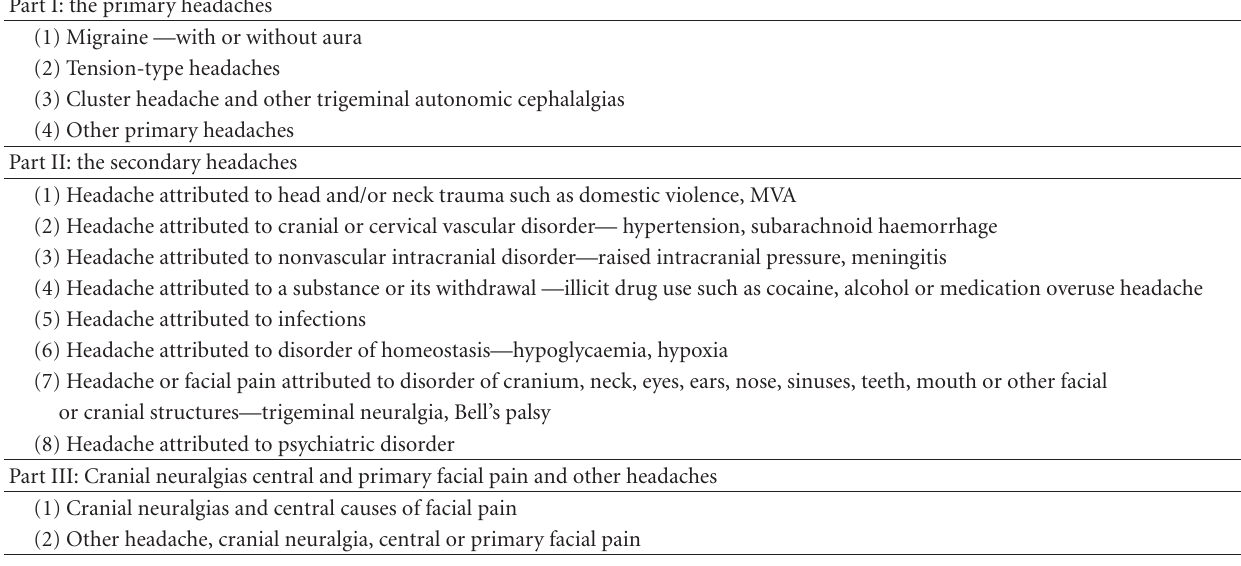
Table 1: International Classification of Headache Disorder